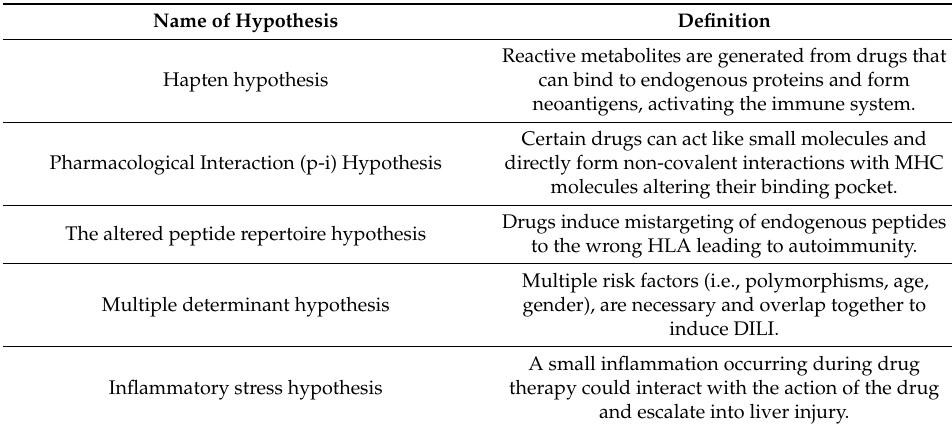
Table 2. Hypotheses of immune system